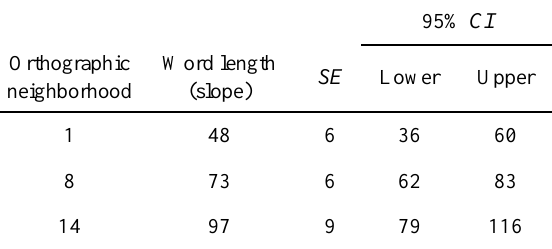
Table A6. Total reading time per word: Interaction of word length and orthographic-neighborhood size.